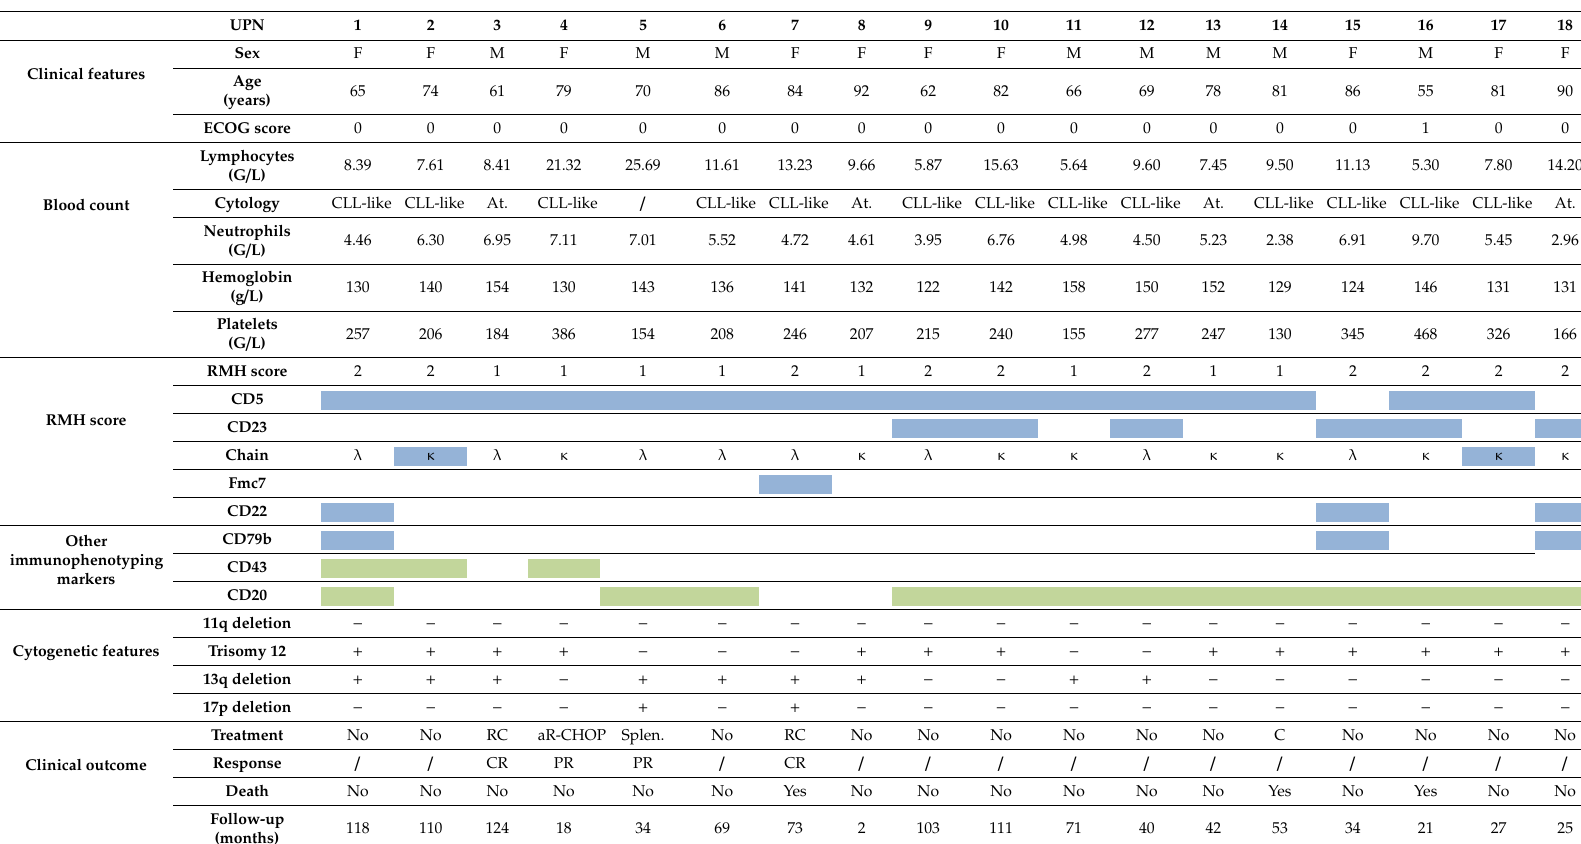
Table 1. Clinico-biological features of the cohort. CLL: Chronic lymphocytic leukemia; UPN: Unique patient number; F: Female; M: Male; ECOG: Eastern Cooperative Oncology Group; RMH: Royal Marsden Hospital; C: Chlorambucil; RC: Rituximab + chlorambucil; aR-CHOP: Attenuated R-CHOP (rituximab + cyclophosphamide + doxorubicin + vincristine + prednisone); Splen.: Splenectomy; CR: Complete response; PR: Partial response